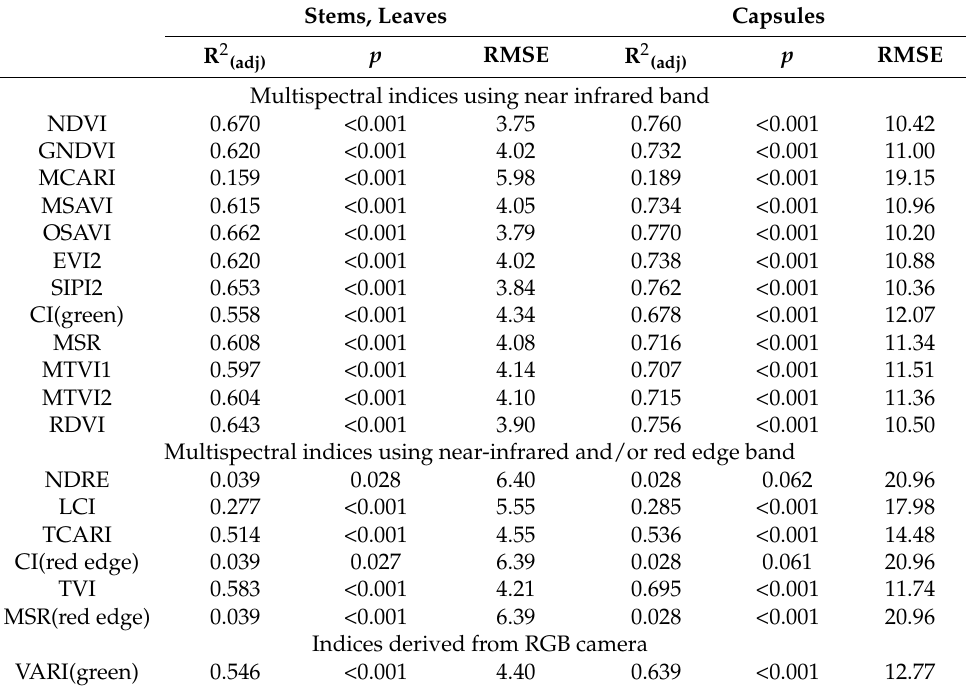
Table 2. Regression coefficients between VIs and moisture content of vegetative (stems % leaves) and reproductive (capsules) plant parts ( n = 112). Stems, Leaves Capsules R 2